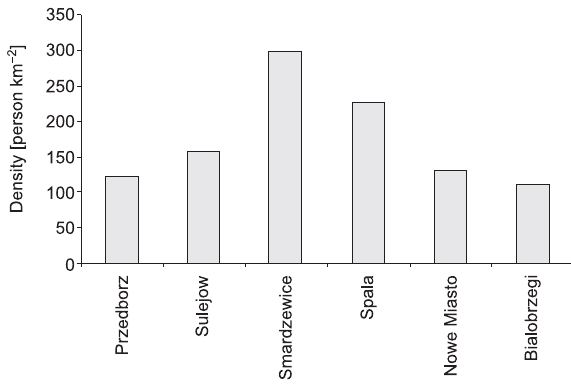
Fig. 4. Population density in the Pilica River sub-catchments